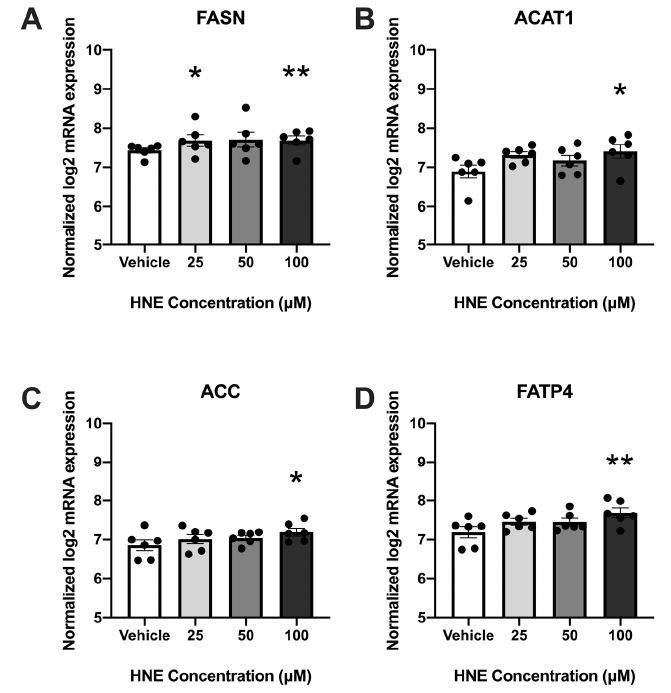
Figure 2. HNE exposure upregulates fa tt y acid metabolism-associated genes in a concentration-de- pendent manner in human placental explants (( A ), FASN; ( B ), ACAT1; ( C ), ACC; ( D ), FATP4); n = 6/group. Data (means ± standard error of the mean) are expressed as normalized log2 mRNA ex- pression. * p < 0.05, ** p < 0.01 vs. vehicle control by non-parametric repeated measures, one-way ANOVA and Dunn’s multiple comparison